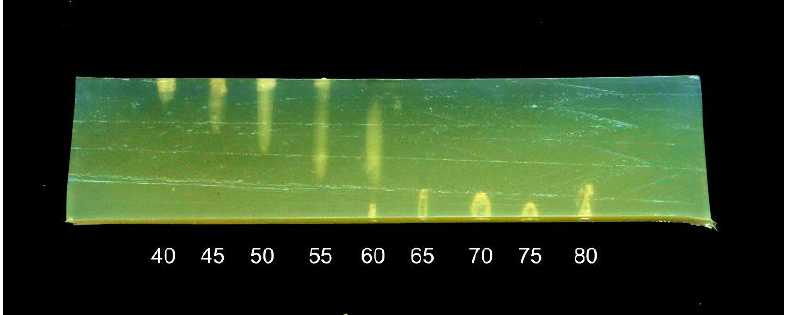
Figure 4. Phantom treated with a 1 MHz transducer for 15 s at distances between 40 and 80 mm (distance marked below each treatment position).The transducer was placed below the phantom.